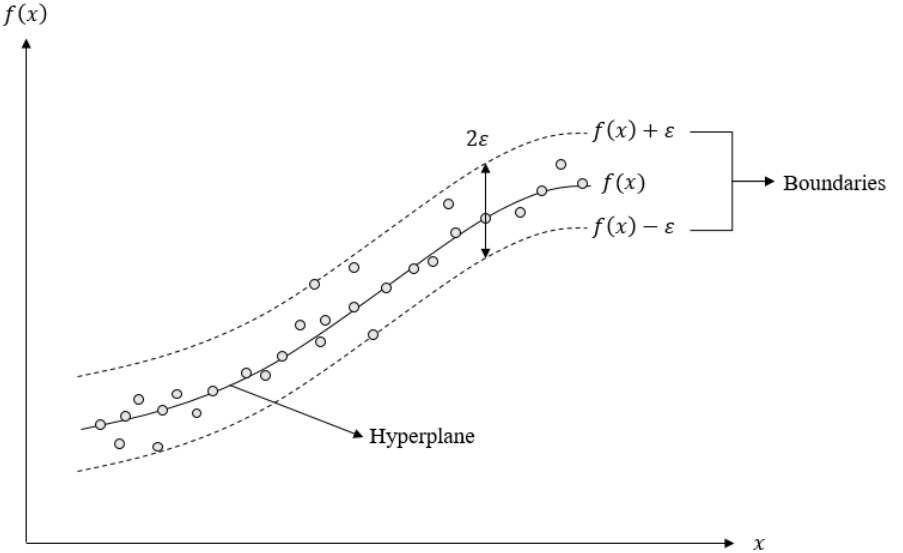
Figure 4. Support Vector Machine (SVM) model.